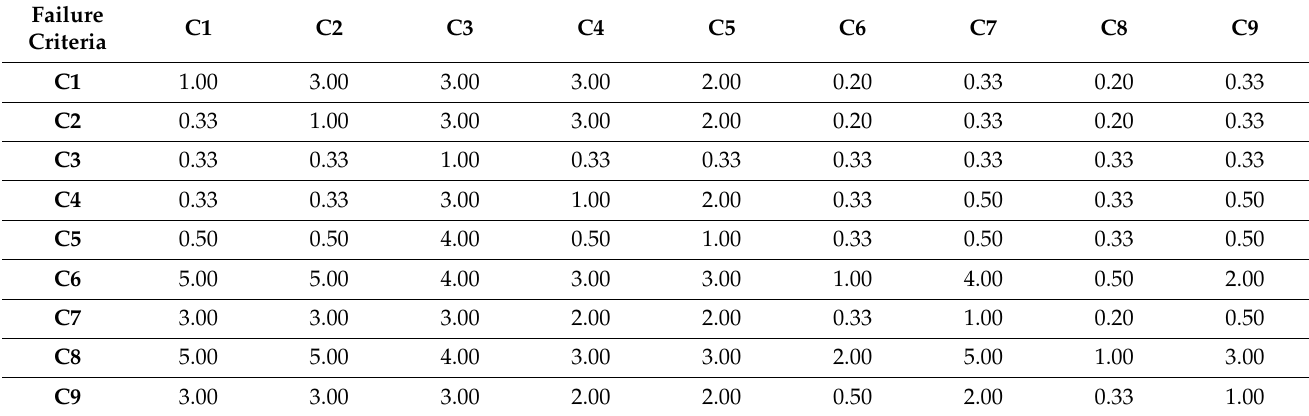
Table 7. The developed PCMs table based on the Saaty’s Scale in Table 4.